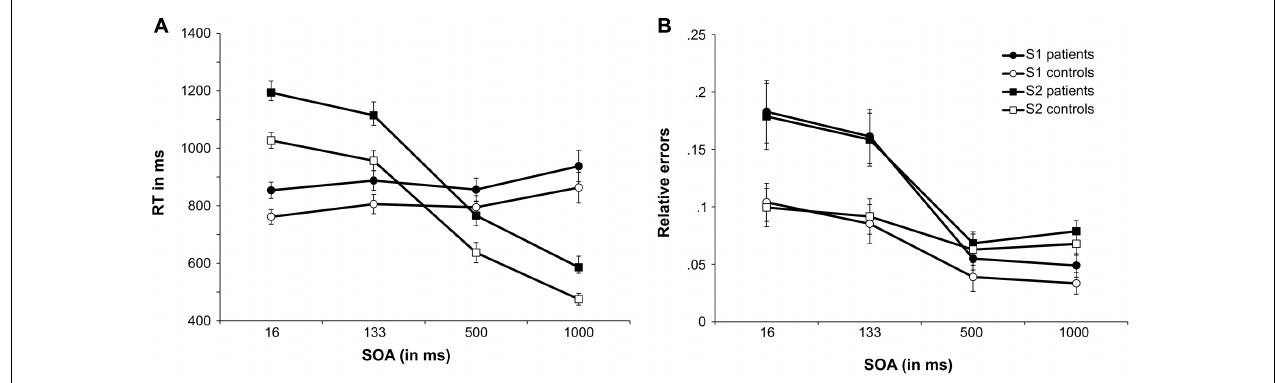
FIGURE 2 | Performance in the PRP task. (A) Shows the mean reaction times (RTs) as a function of SOA length for the tone task (S1 stimulus) and the letter task (S2 stimulus) for the MS patients group and controls. (B) Shows the mean relative number of errors as a function of SOA length for the tone task (S1 stimulus) and the letter task (S2 stimulus) for the MS patients group and controls. Error bars denote the standard error of the mean (SEM).